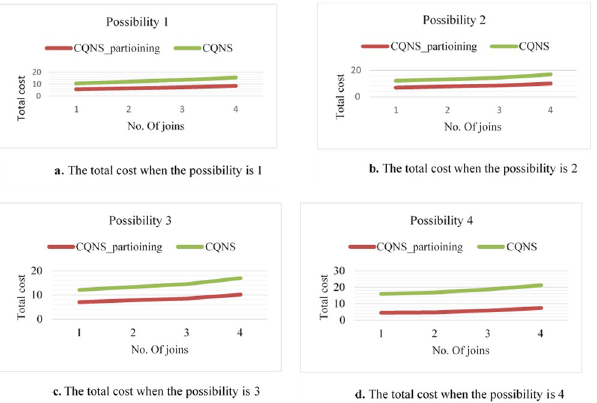
Fig 19. Comparison of the total cost using CQNS in CASSANDRA with edge partitioning and CQNS without partitioning on star joins.